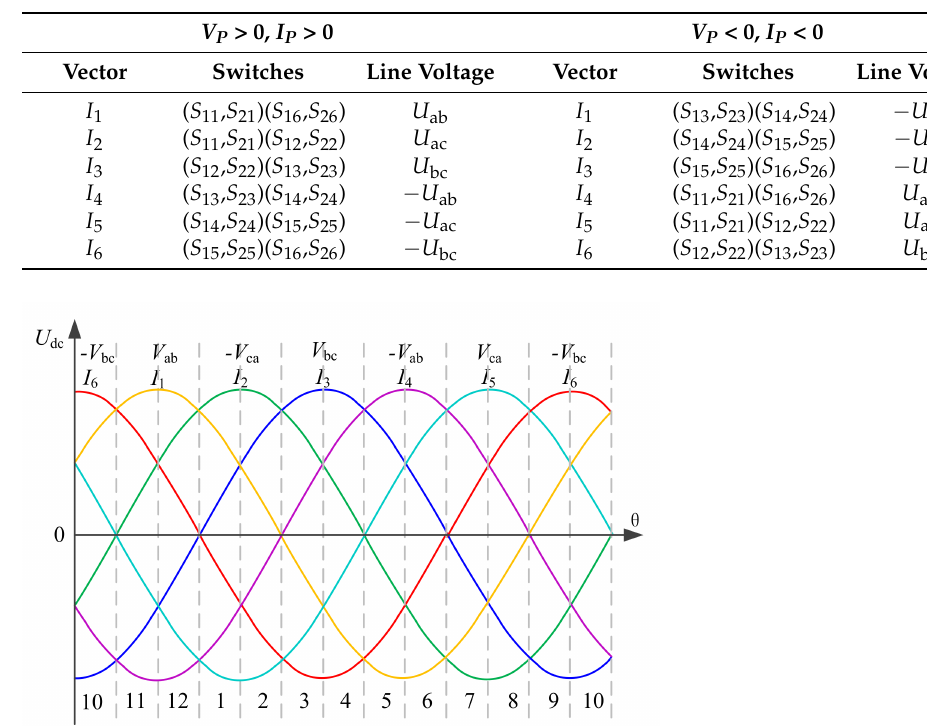
Table 2. The corresponding switching sequence and the output voltage.